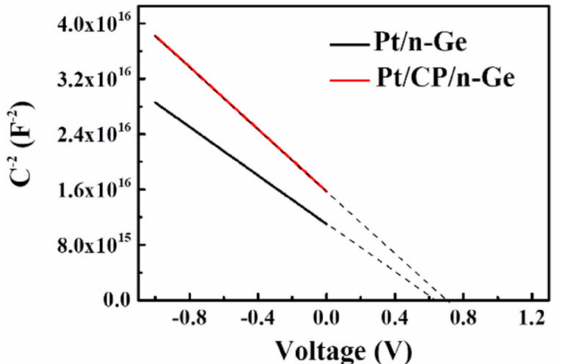
Figure 5. A 2 /C 2 –V characteristics for Pt/n-Ge Schottky diodes with and without a CP interlayer.